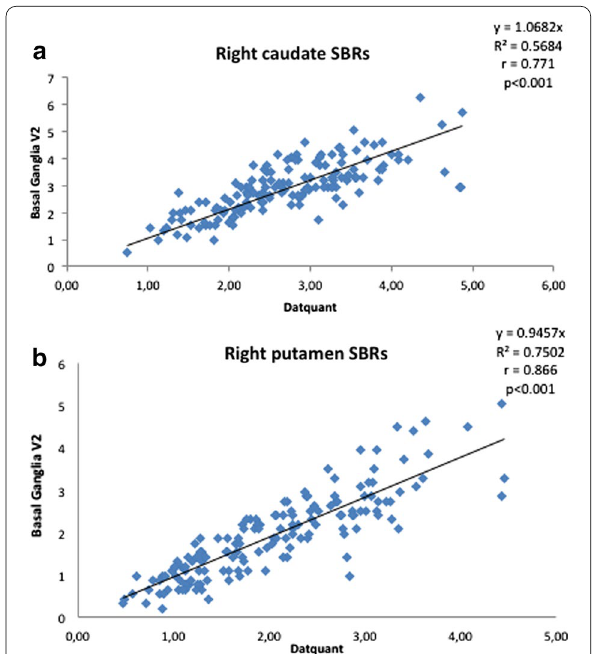
Fig. 1 Plot of linear correlation between the SBR of the caudate nucleus ( a ) and of the putamen ( b ) as achieved with Datquant ® ( x -axis) and BasGanV2 ( y -axis) in 151 subjects. Intercept equation, R 2 , r